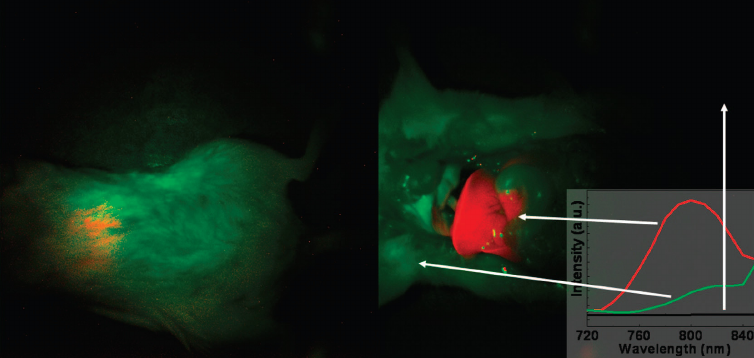
Figure 4. In vivo imaging of a mouse with the injection of UCNPs: intact mouse ( left ); the same mouse after dissection ( right ). The red color indicates emission from UCNPs; green and black show the background, as indicated by the arrows. The inset presents the photoluminescence spectra corresponding to the spectrally unmixed components of the multispectral image obtained with the Maestro system. Adapted with permission from reference [78]. Copyright: American Chemical Society,